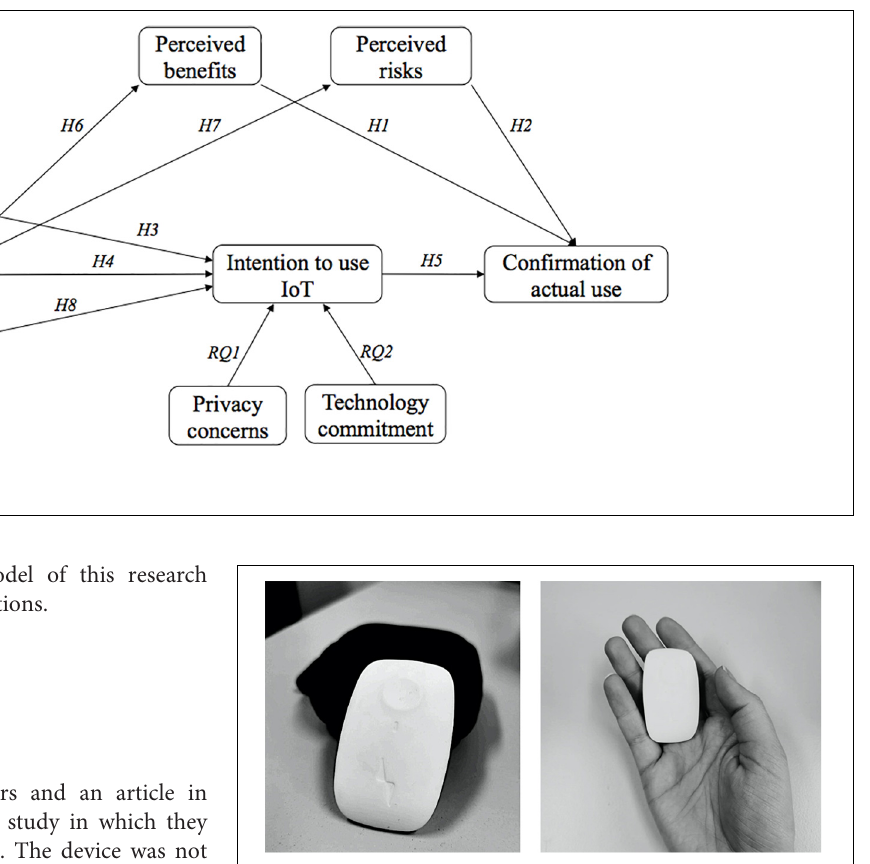
FIGURE 2 | Pictures of the IoT device deployed in the study (i.e., Upright